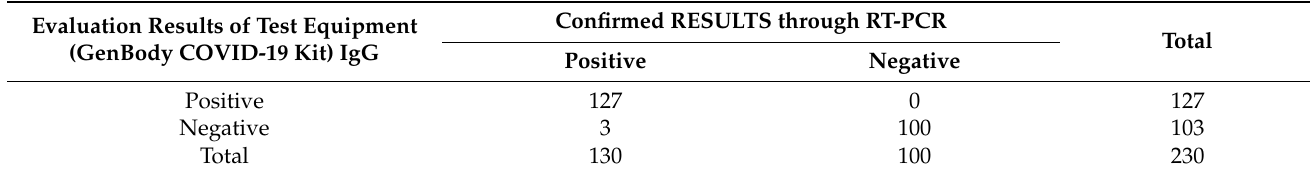
Table 4. IgG antibody test results using the GenBody™ COVI040 assay.